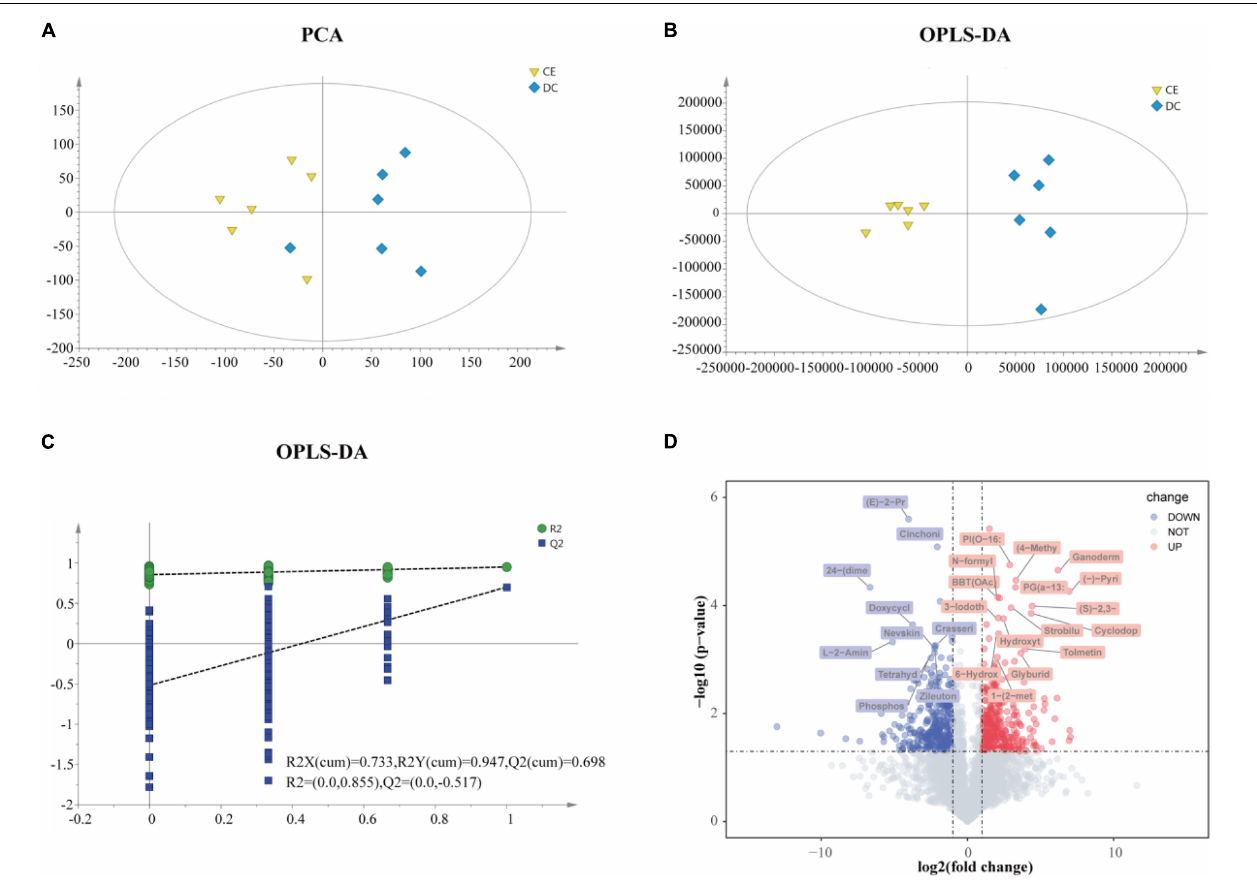
FIGURE 5 | The gut metabolites were remarkably perturbed by adding CE ( n = 6 hens/group). (A) Principal component analyses (PCA) of ileum metabolome. (B) Orthogonal projections to latent structures-discriminate analysis (OPLS-DA) score plot was performed on ileum in DC and CE groups. In the permutation validation plot (C) (200 cycles) the Y -axis intercepts of R 2 and Q 2 are 0.855 and − 0.517, respectively, indicating that the model is valid. (D) Volcano plots of ileum profiles showing log 2 (fold-change) and − log 10 ( p -value) in metabolites levels induced by adding CE (up-regulated in red and down-regulated in green). The labeled metabolites were of particular interest (| fold change| > 4, p < 0.001).